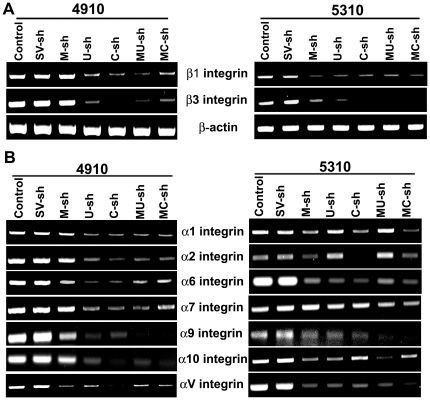
RT-PCR analysis of integrins.(A) RT-PCR analysis of 4910 and 5310 cells transfected with scrambled vector (SV-sh), MMP-9 (M-sh), uPAR (U-sh), cathepsin B (C-sh), MMP-9/uPAR (MU-sh) and MMP-9/cathepsin B (MC-sh) plasmid shRNAs, showing the mRNA expressions of β integrins (β1 and β3) (A) and α integrins (α1, α2, α6, α7, α9, α10, and αV) (B).